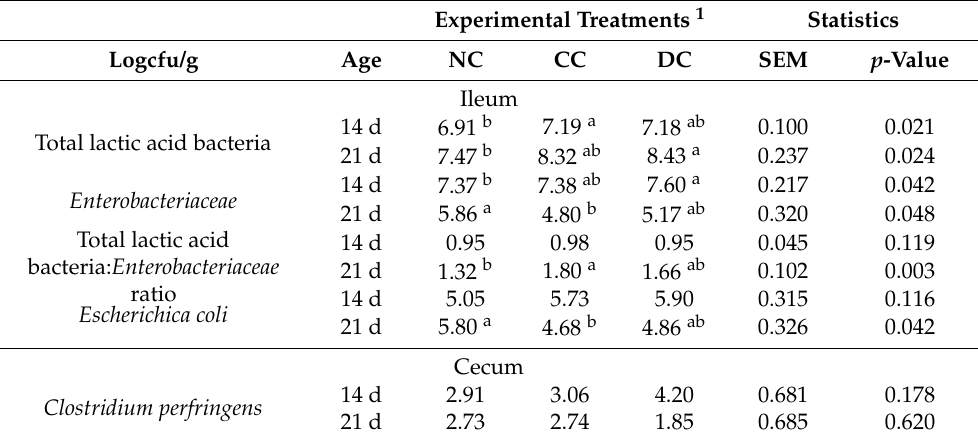
Table 10. Effects of treatments on ileal and cecal microbial counts at 7 and 14 days post-inoculation with the coccidial inoculum (Experiment 2).